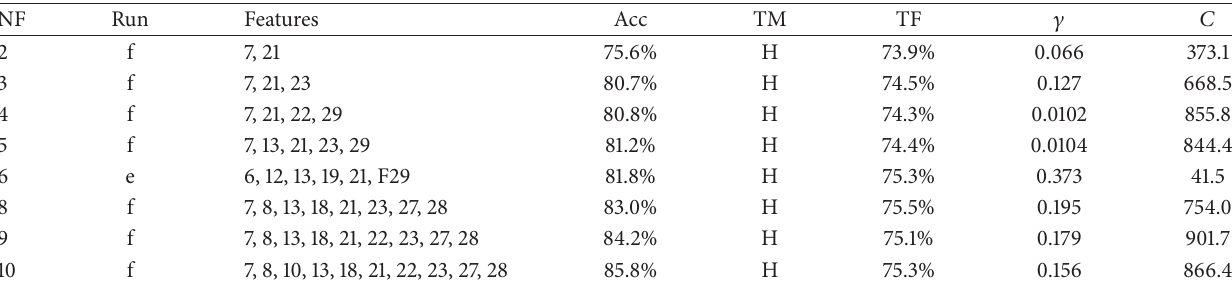
Table 5: Optimal solutions for Experiment 2 (Diane 2005 database).